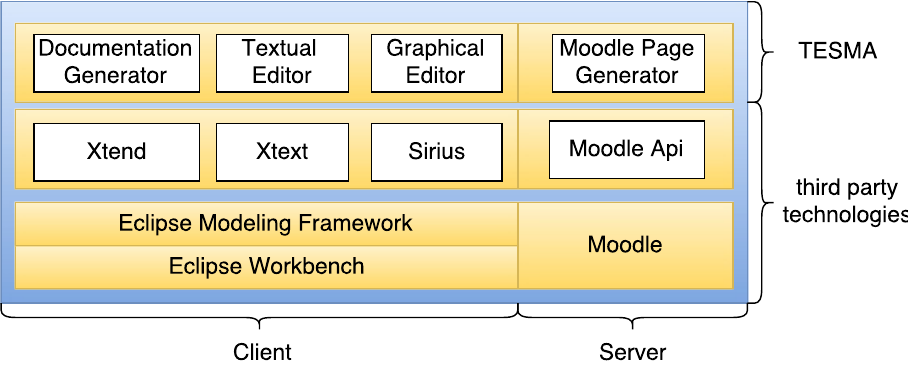
Figure 3. Architectural components